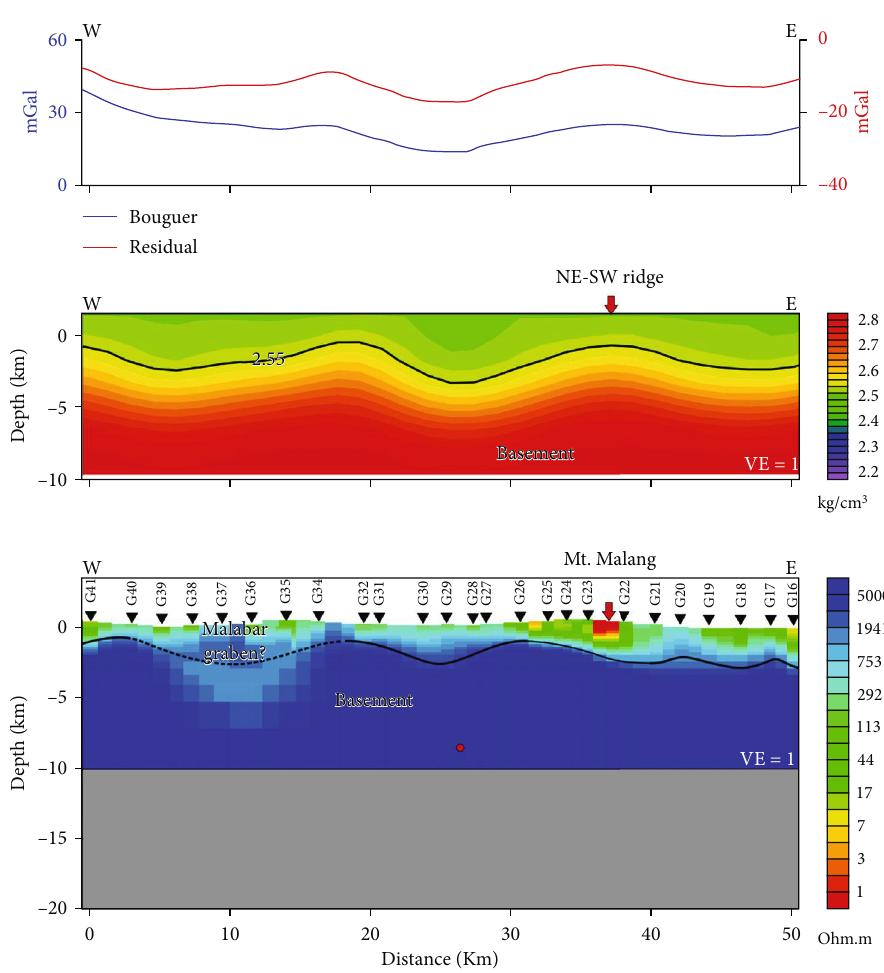
Figure 14: Interpretation of the density (top) and resistivity (bottom) models of line C-C ′ . Interesting feature is observed at Mt. Malang, which is characterized by high-density and low-resistivity